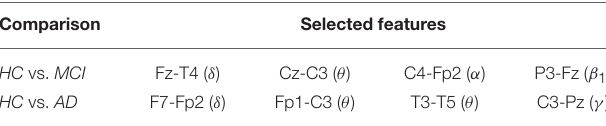
TABLE 4 | Optimal FCBF sets of features for HC vs. MCI and HC vs. AD comparisons.